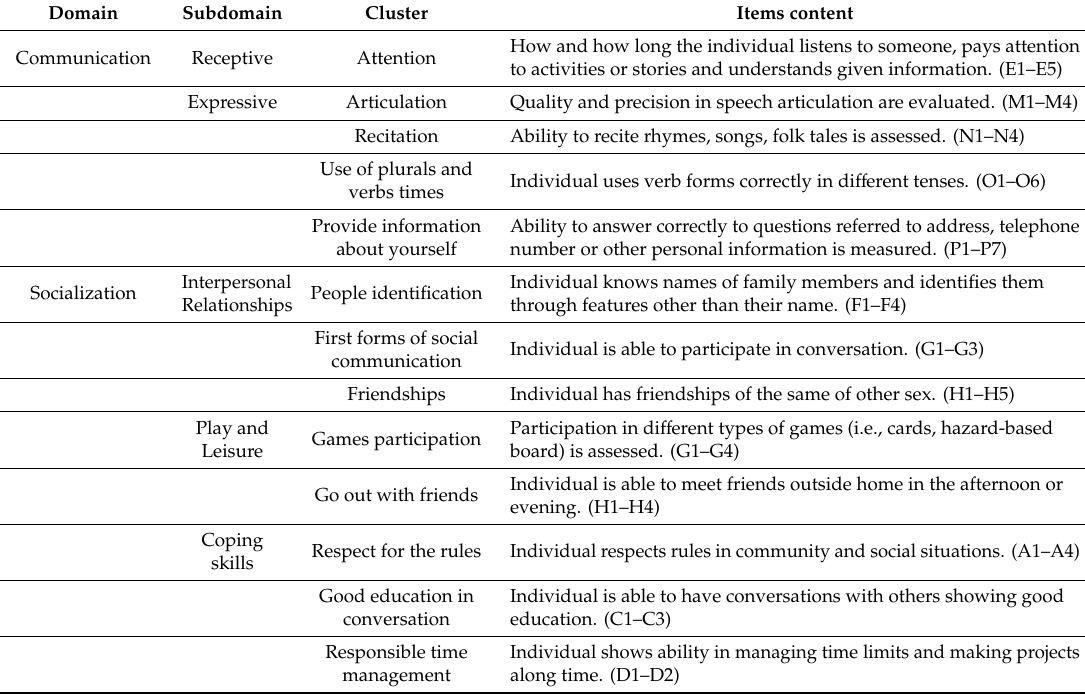
Table 1. Vineland adaptive behavior scales organized by domains, subdomains, clusters and item content: Significant